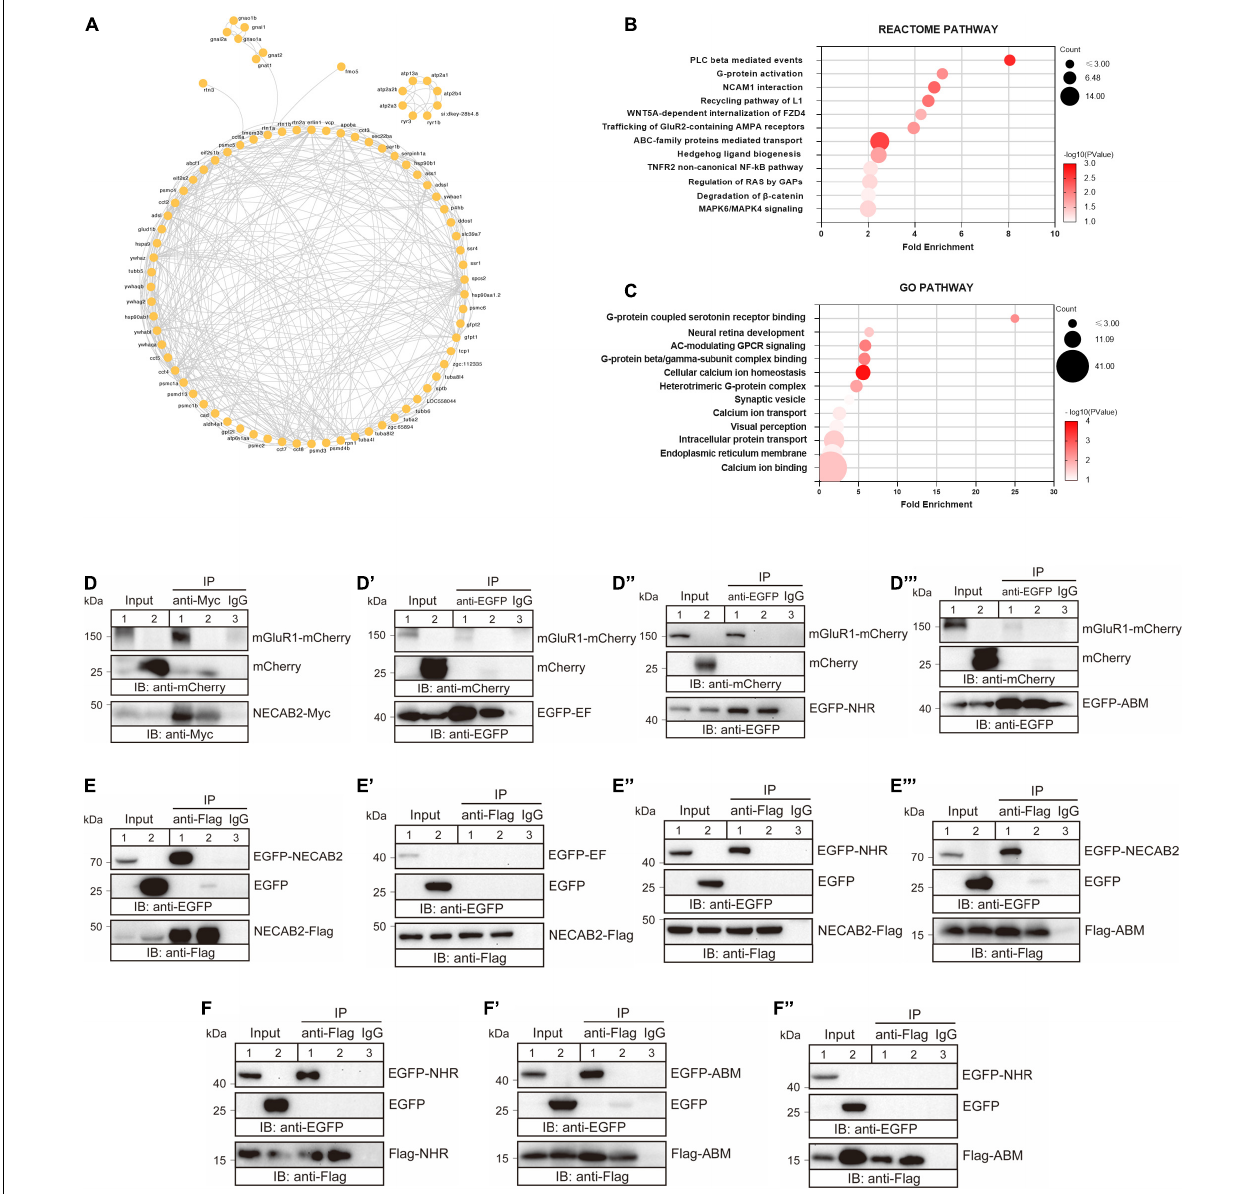
FIGURE 6 | NECAB2 interacts with mGluR1 in vitro . (A) Overview of the protein interaction network derived from the Necab2 co-immunoprecipitation and subsequent mass spectrometry in the necab2 + / + and necab2 − / − larvae. (B) REACTOME analysis revealed the significant biological processes detected in the necab2 + / + larvae compared to the necab2 − / − larvae. (C) Gene Ontology (GO) analysis revealed the significant biological processes detected in the necab2 + / + larvae compared to the necab2 − / − larvae. (D–D (cid:48)(cid:48)(cid:48) ) NECAB2 interacts with mGluR1 through the NHR domain uncovered by co-immunoprecipitation analysis. The HEK293 cells were transiently transfected with mGluR1-mCherry plus NECAB2-Myc (D) , EGFP-EF (D (cid:48) ) , EGFP-NHR (D (cid:48)(cid:48) ) , or EGFP-ABM (D (cid:48)(cid:48)(cid:48) ) for lane 1 and lane 3 respectively, and indicated vectors plus mCherry-vector for lane 2 and processed for immunoprecipitation using mouse anti-Myc antibody (D) or anti-EGFP antibody (D–D (cid:48)(cid:48)(cid:48) ) , with normal mouse IgG for negative control in lane3. The crude extracts (Input) and immunoprecipitations (IP) were analyzed by SDS-PAGE and immunoblotted using the rabbit anti-mCherry antibody (D–D (cid:48)(cid:48)(cid:48) ) , mouse anti-Myc antibody (D) or mouse anti-EGFP antibody (D (cid:48) –D (cid:48)(cid:48)(cid:48) ) . (E–E (cid:48)(cid:48)(cid:48) ) NECAB2 has self-interaction through either NHR or ABM domain uncovered by co-immunoprecipitation analysis. The HEK293 cells were transiently transfected with NECAB2-Flag plus EGFP-NECAB2 (E) , NECAB2-Flag plus EGFP-EF (E (cid:48) ) , NECAB2-Flag plus EGFP-NHR (E (cid:48)(cid:48) ) , or NECAB2-Flag plus EGFP-ABM (E (cid:48)(cid:48)(cid:48) ) for lane 1 and lane 3, and the indicated vectors plus EGFP-vector for lane 2 and processed for immunoprecipitation using mouse anti-Flag antibody, with normal mouse IgG for negative control in lane 3. The crude extracts (Input) and immunoprecipitations (IP) were analyzed by SDS-PAGE and immunoblotted using mouse anti-EGFP antibody (E–E (cid:48)(cid:48)(cid:48) ) or mouse anti-Flag antibody (E–E (cid:48)(cid:48)(cid:48) ) . (F–F (cid:48)(cid:48) ) Co-immunoprecipitation analysis of NHR and ABM domains showed self-interaction but no cross-interaction of the two domains. The HEK293 cells were transiently transfected with Flag-NHR plus EGFP-NHR (F) , Flag-ABM plus EGFP-ABM (F (cid:48) ) , and Flag-ABM plus EGFP-NHR (F (cid:48)(cid:48) ) for lane 1 and lane 3, and indicated vectors plus EGFP-vector for lane 2 and processed for immunoprecipitation using the mouse anti-Flag antibody, with normal mouse IgG for negative control in lane3. The crude extracts (Input) and immunoprecipitations (IP) were analyzed by SDS-PAGE and immunoblotted mouse anti-Flag antibody (F–F (cid:48)(cid:48) ) or mouse anti-EGFP antibody (F–F (cid:48)(cid:48) ) .